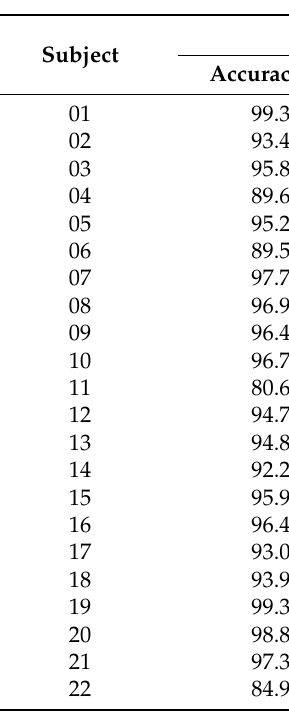
Table 2. Subject-dependent average classification